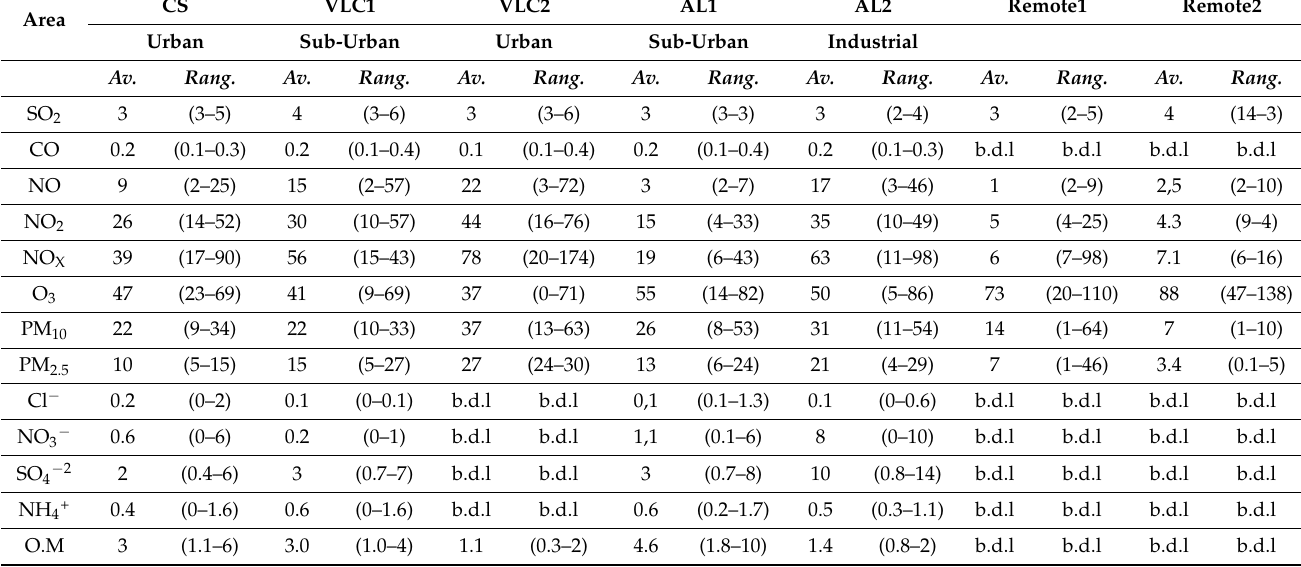
Table 1. Average concentration and ranges in µ g m − 3 of main gaseous pollutants, particulate matter (PM) mass fractions, inorganic anions in fine fraction, and organic matter in the western Mediterranean area for twelve months.